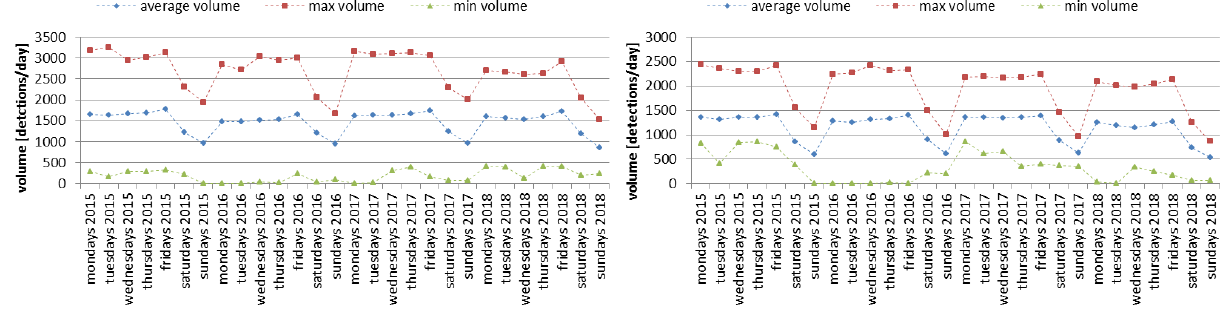
Figure 12: Number of detections per consecutive days of the week of 2015-2018 period for Route 1 and Route